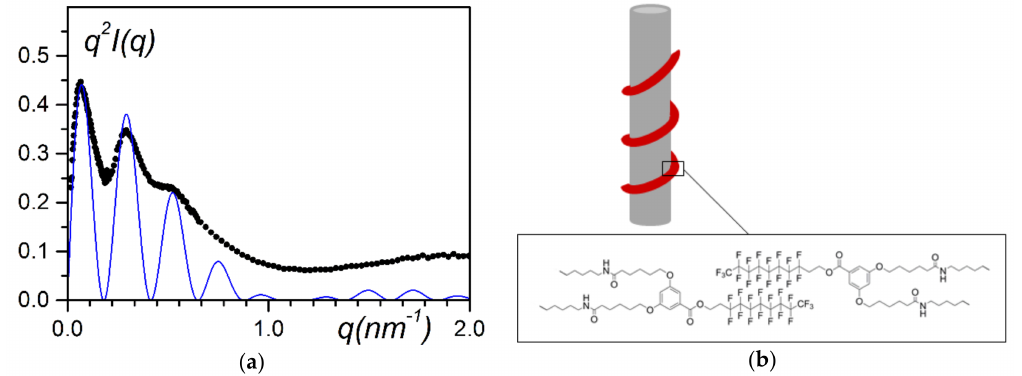
Figure 13. ( a ) SANS data plotted by means of a Kratky-plot, q 2 I(q) vs. q.; = sPSD/bhpbfH/o-xyleneD (C bhpbfH = 0.01 g/cm 3 , C sPSD = 0.15 g/cm 3 ); solid line= fit with Equation (9). ( b ) Model designated as “bindweed”, where bhpbf irregular helices wind around polymer fibrils